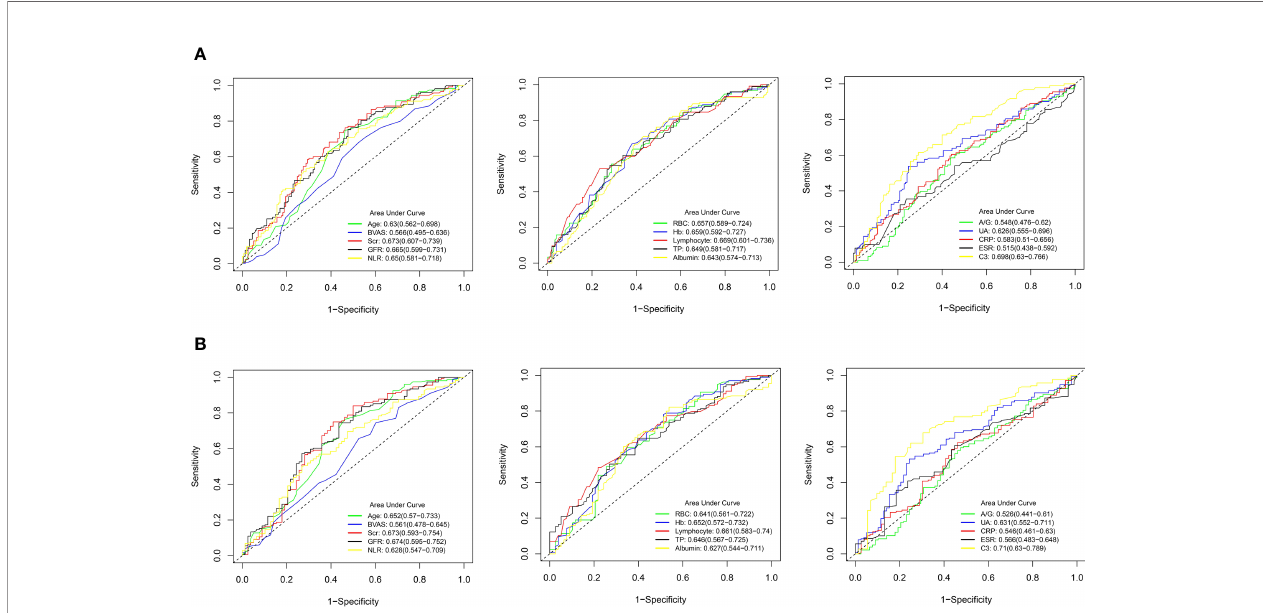
FIGURE 3 | Receiver operating characteristic (ROC) curves for the predictive ability of clinical parameters with continuous variables in AAV patients. (A) 3-year survival rate. (B) 5-year survival rate. AAV, antineutrophil cytoplasmic antibody (ANCA)-associated vasculitis; BVAS, Birmingham vasculitis activity score; Scr, serum creatinine; GFR, glomerular fi ltration rate; NLR, neutrophil-to-lymphocyte ratio; RBC, red blood cell; Hb, hemoglobin; TP, total protein; A/G, albumin-to-globulin ratio; UA, uric acid; CRP, C-reactive protein; ESR, erythrocyte sedimentation rate; C3, complement